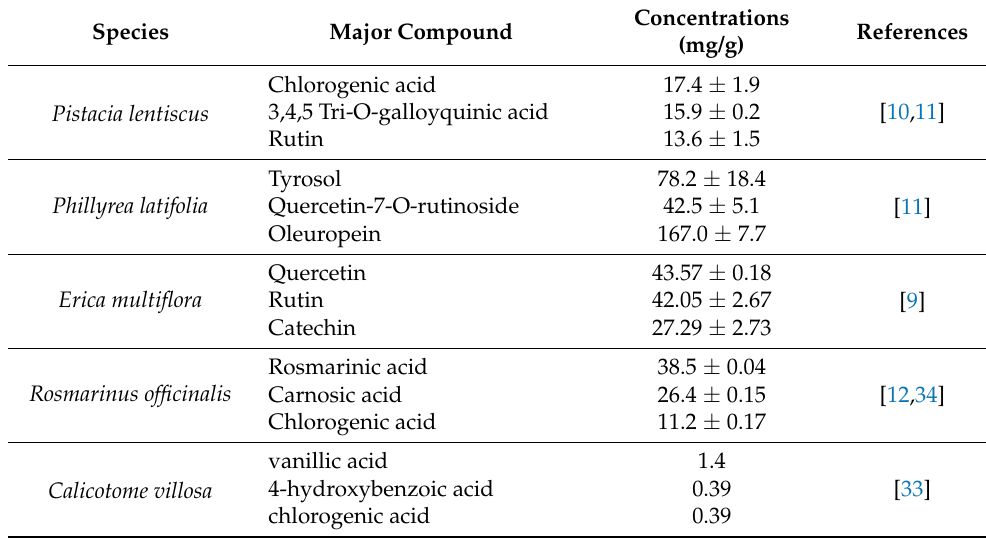
Table 5. Phenolics composition of ethanolic extract of studied species. Results are reported as the mean ± standard deviations (SD) of three